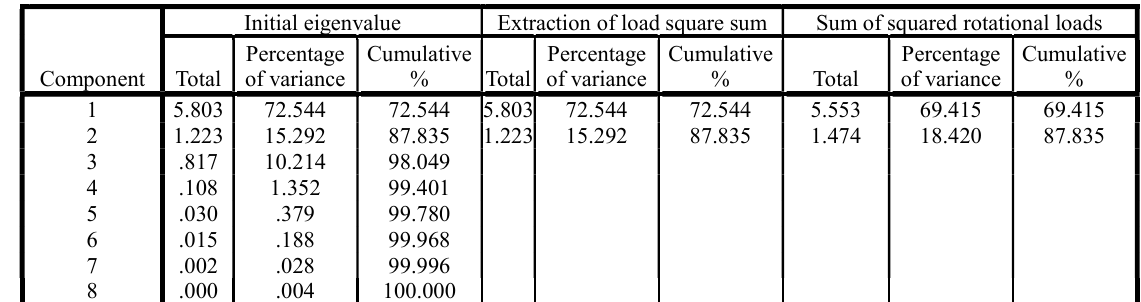
Table 3-1 interpretation of total variance